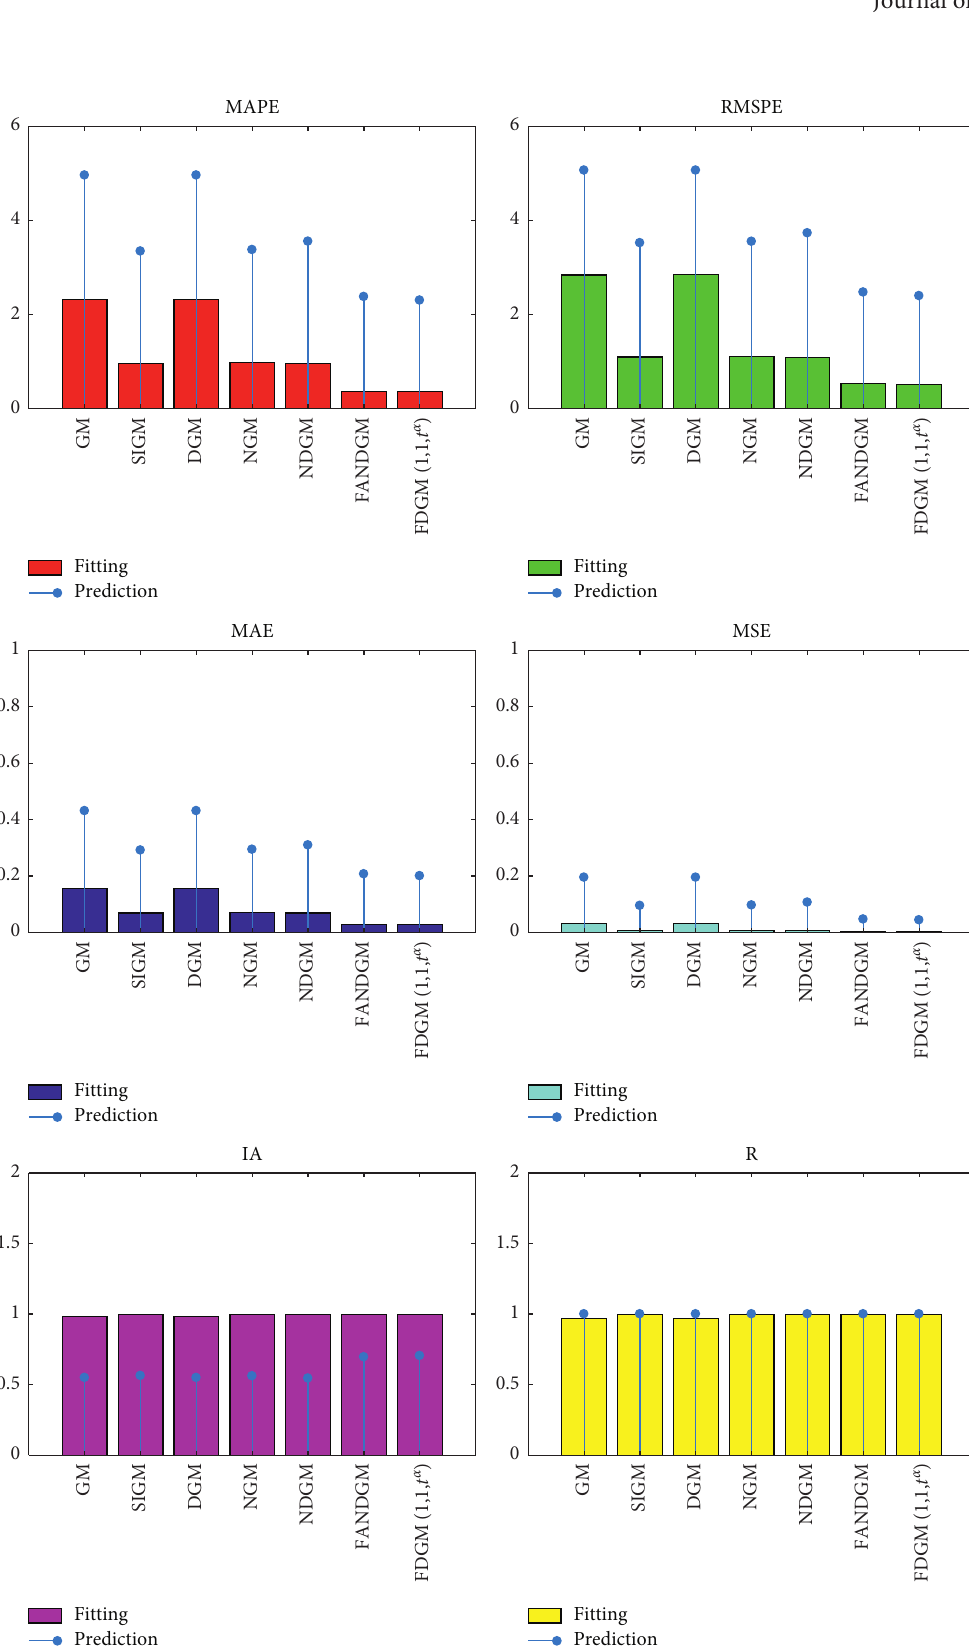
Figure 5: Error metrics of total energy consumption of civil